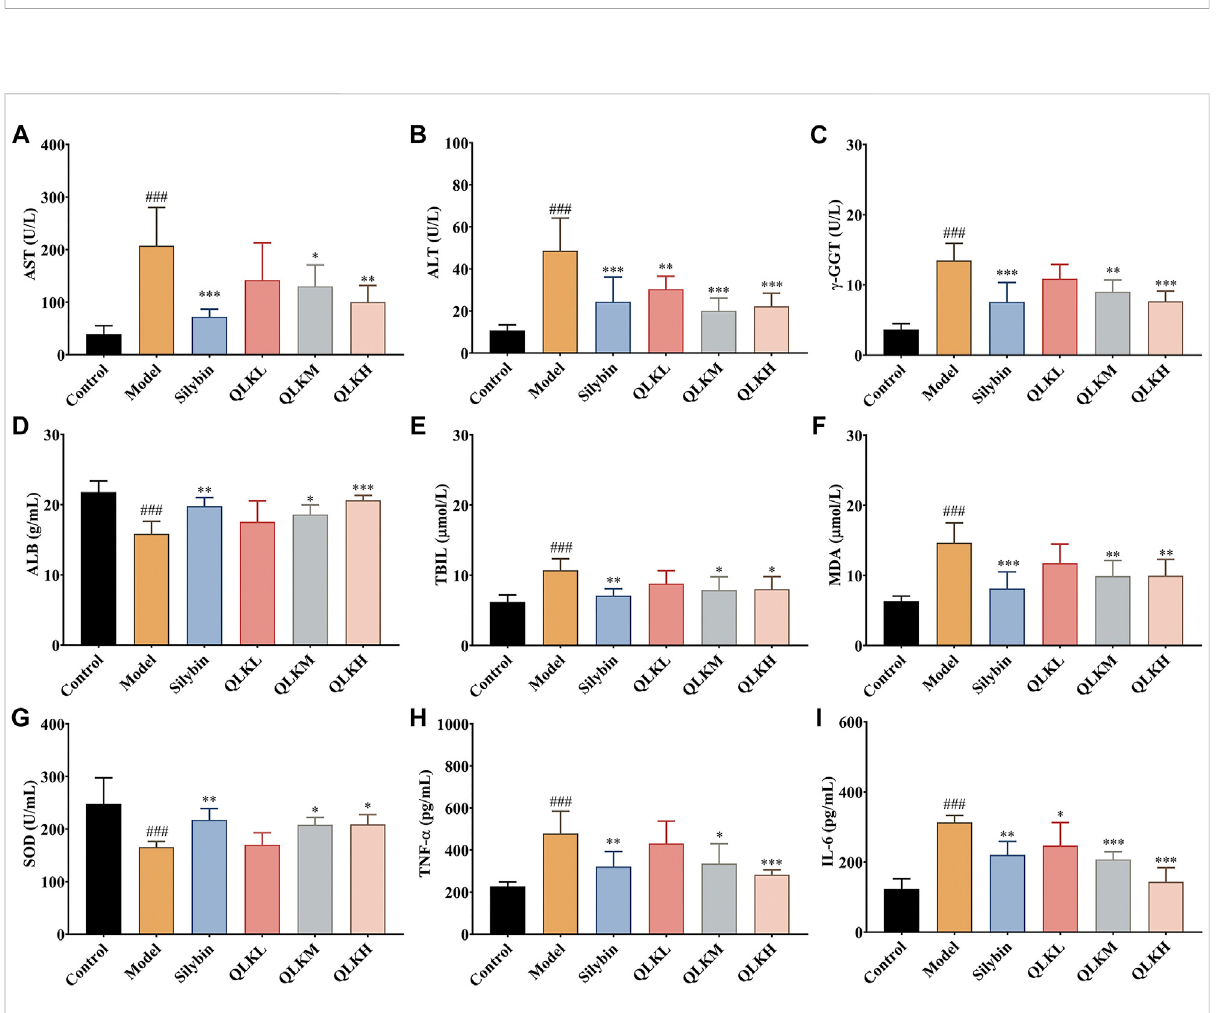
FIGURE 5 Effect of QLK treatment on the levels of serum biochemical indices in CCL 4 rats ( n = 6). (A) Serum AST; (B) Serum ALT; (C) Serum γ -GGT; (D) SerumALB; (E) SerumTBIL; (F) SerumMDA; (G) SerumSOD; (H) SerumTNF- α ; (I) SerumIL-6;Valuesarepresentedasmean±SDforthreebiological replicates per group. * p < 0.05, ** p < 0.01, *** p < 0.005 vs. model, ### p < 0.005 vs. control. QLK,